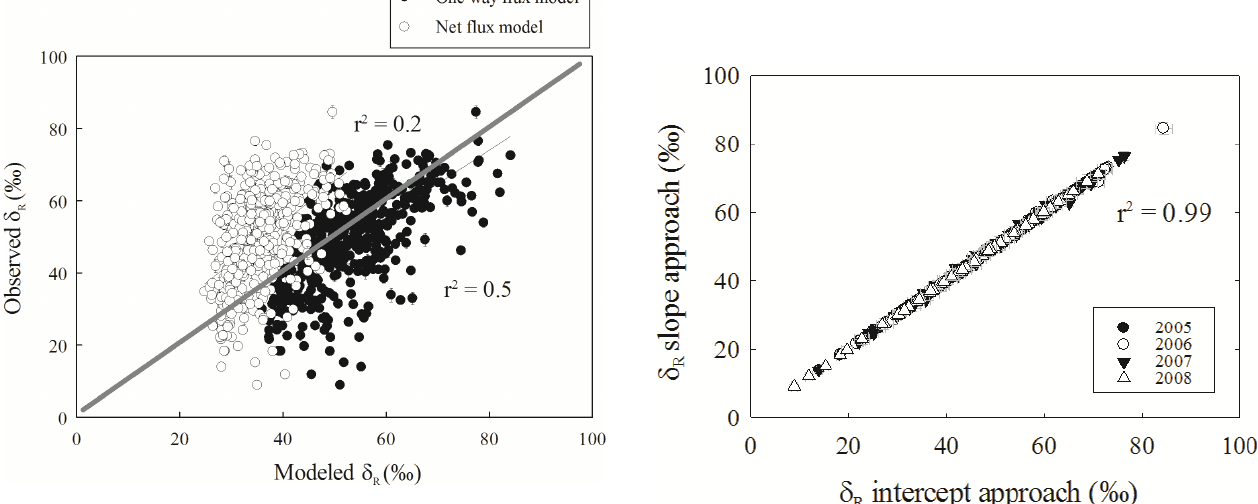
Fig. A5. 1 : 1 Relationships of δ R calculations from the Keeling plots (intercept approach) and Miller/Tans formulation (slope ap-